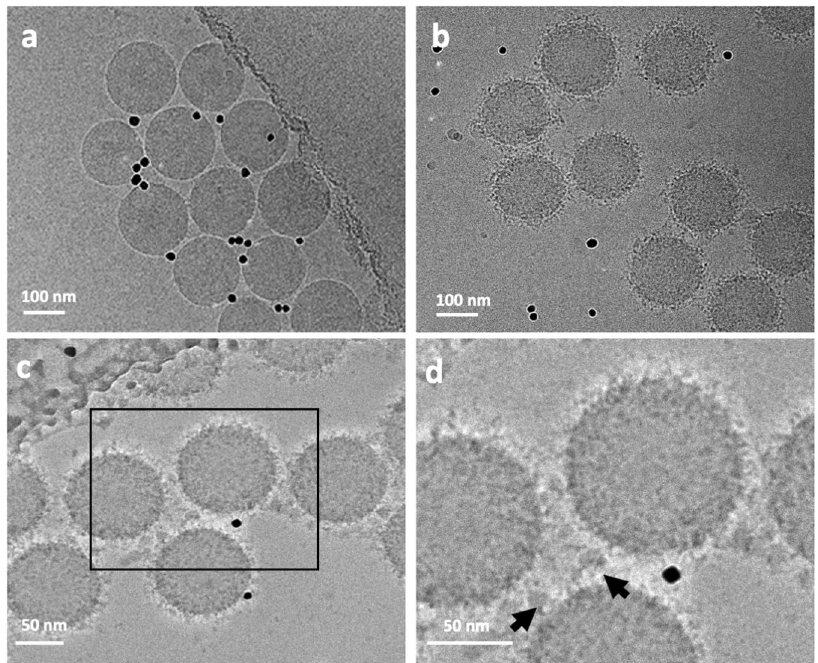
Fig. 2 Cryo-EM images of the PS-COOH NPs obtained with a direct electron detector and phase plate. a Original NPs without corona; b NPs with corona; c , d higher magni fi cation of the NPs showing the distribution of biomolecules and their association with the surface of the NPs. Nonspeci fi c proteins accumulate between the NPs as large clusters (black arrows). The black dots in the images are 10 nm gold fi ducial markers.